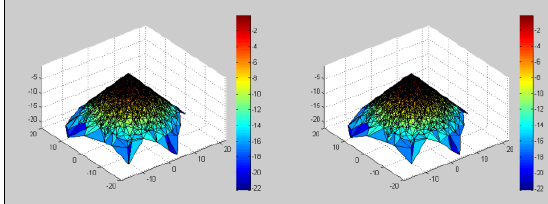
Figure 5: The third pair of surfaces, with 5000 points and 9055 triangles each.